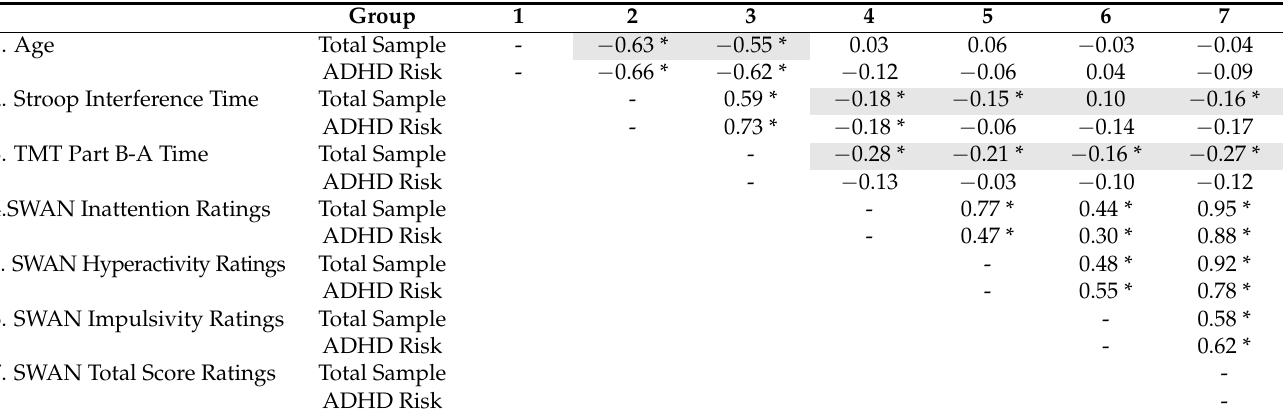
Table 2. Correlations between age, EF tasks and parent reports of impulse and attention regulation in the full sample.